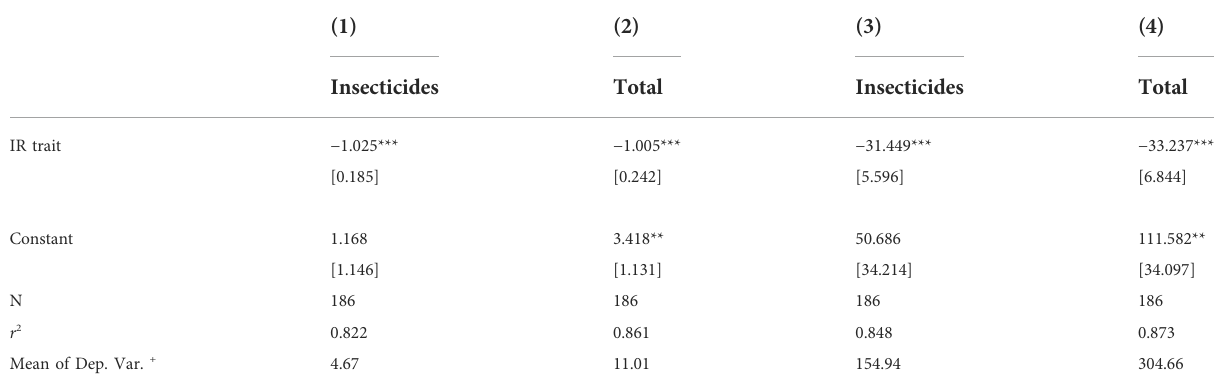
TABLE 1 Effect of IR trait on quantity and fi eld EIQ of insecticides and total pesticides.